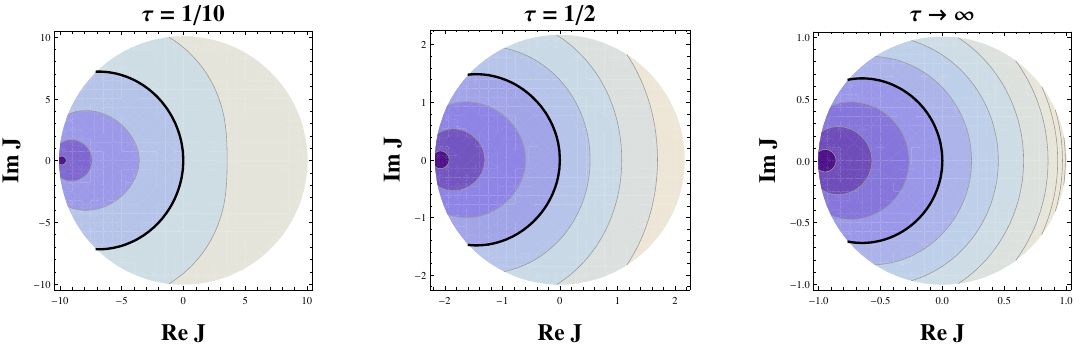
Figure 3 . Three contour plots of (2.17) for times (cid:28) = 0 : 1 ; : 5 ; 1 . The black thick curve in each plot is the level curve of value 1, formed by instantons which do not change the complex